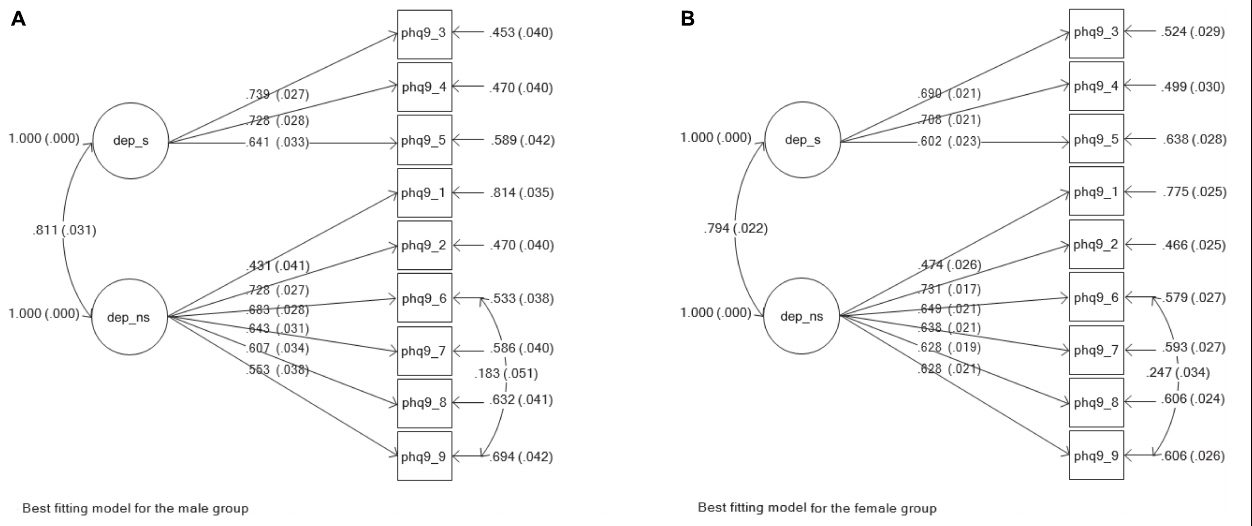
FIGURE 1 | Best fitting models for the measuring instrument of depression (PHO-9). (A) Best fitting model for the male group. (B) Best fitting model for the female